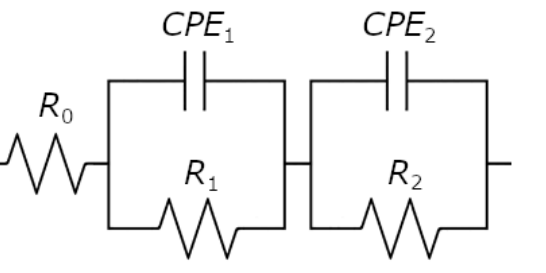
Figure 6. Equivalent electrical circuit model for the corrosion process used for CNLS-fitting.